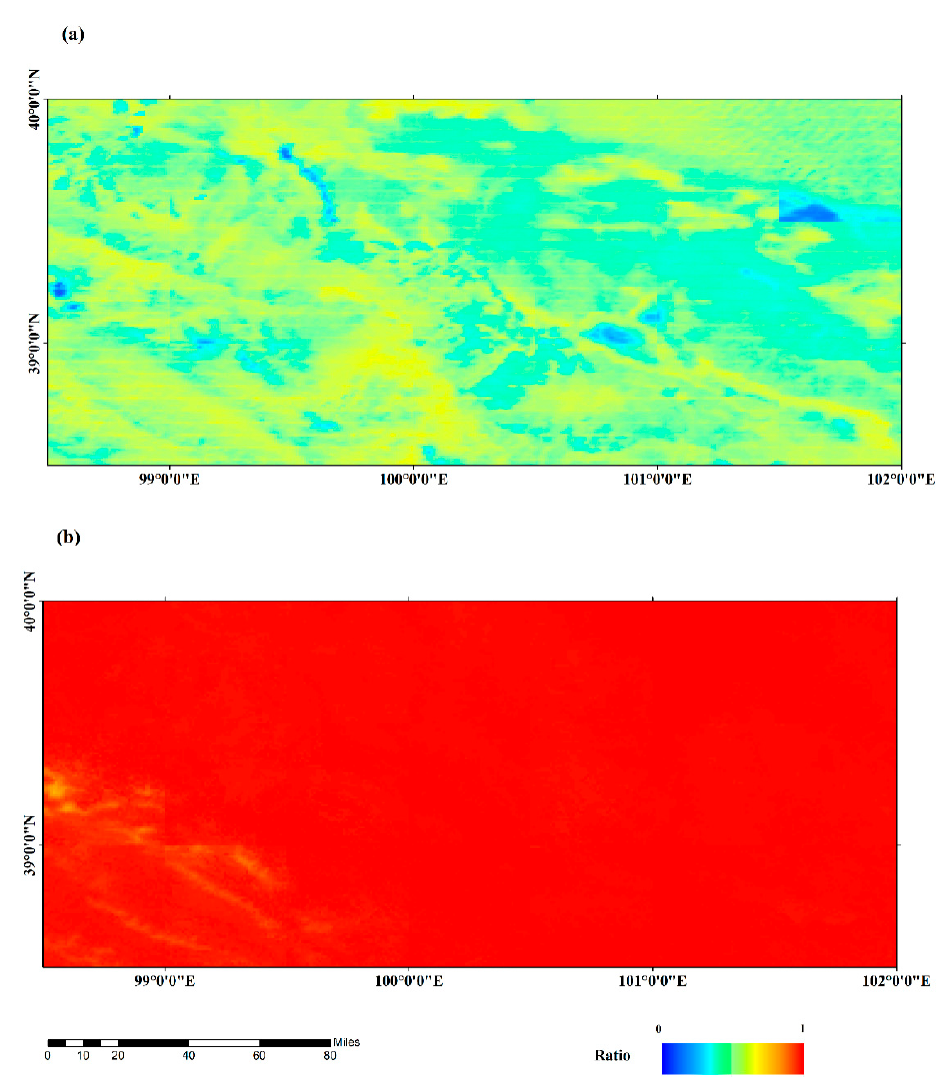
Figure 6. Coverage of LST: ( a ) before reconstruction, ( b ) after reconstruction, where LST: land sur- face temperature.